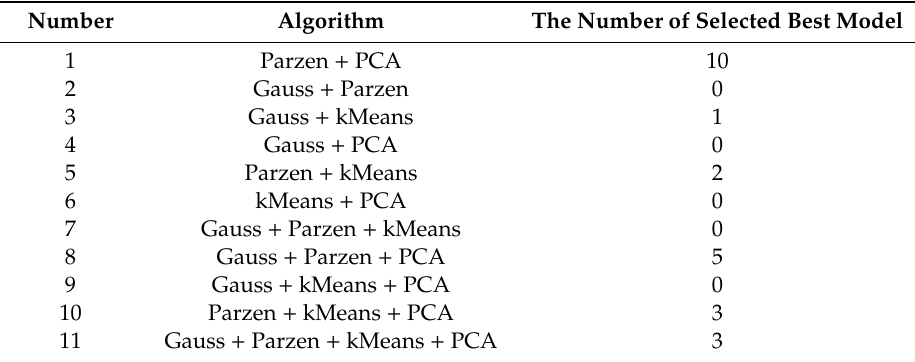
Table A7. The number of selected best model for each ensemble